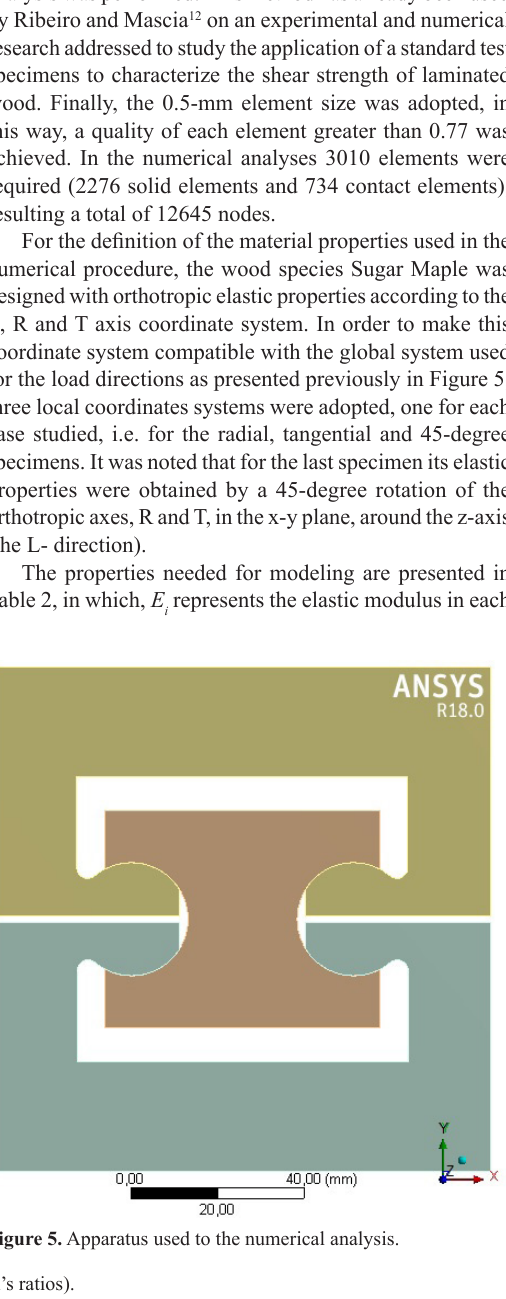
Table 2. Elastic Properties for Maple sugar (in MPa, except the Poisson’s ratios). E